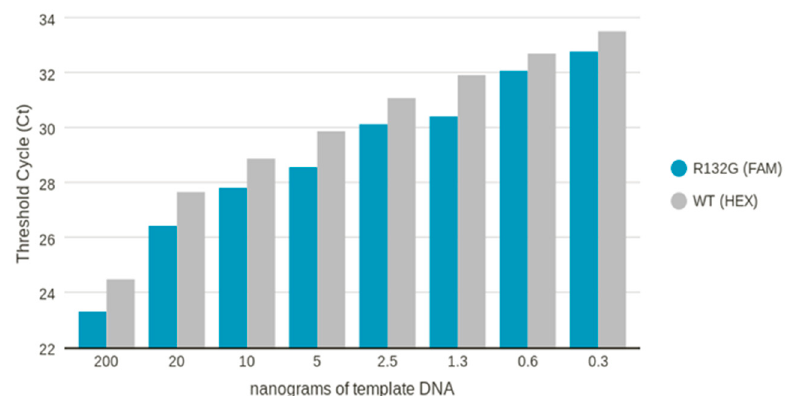
Figure 1. Mean Ct obtained on diluted genomic DNA isolated from R132G mutated sample.